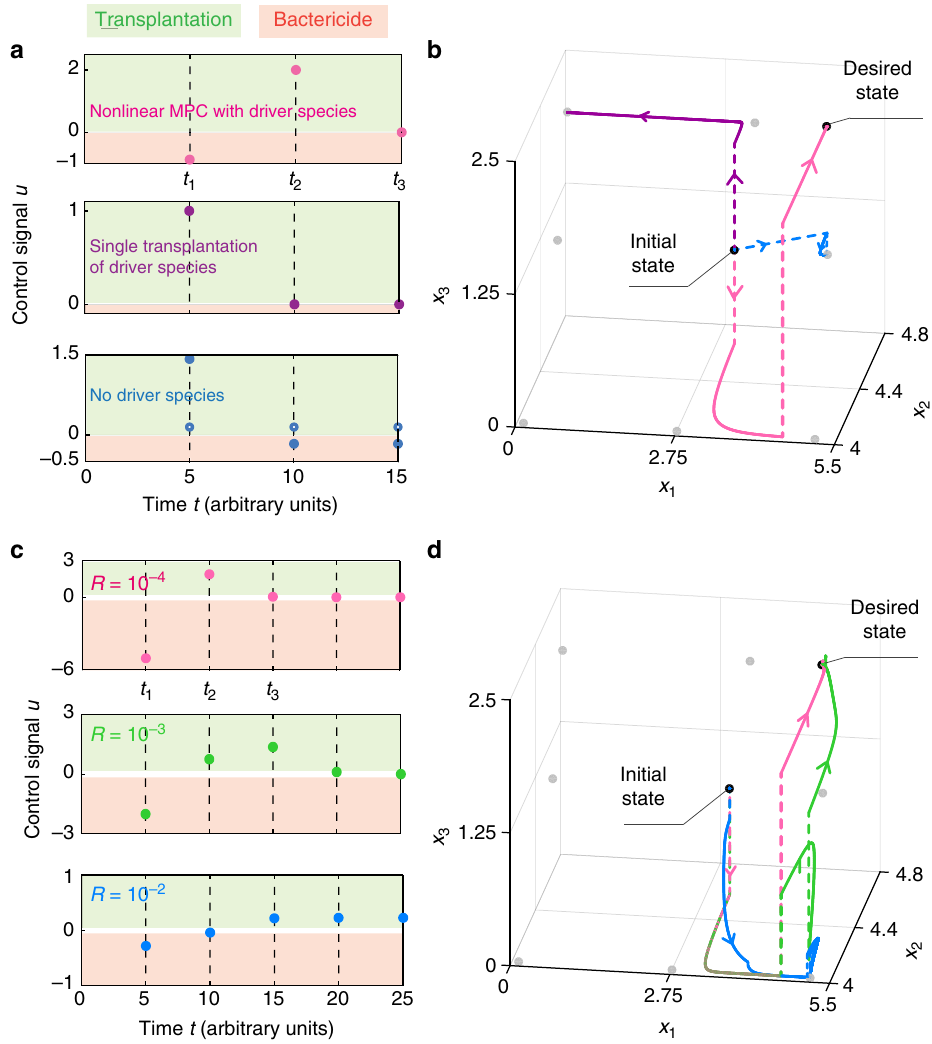
Fig. 4 Success and failure of different control strategies. a Three control strategies for driving the microbial community of Fig. 1a toward the desired state. First, MPC applied to the identi fi ed driver species {x 3 } (pink dots). The second control strategy increases the abundance of the driver species to match its value at the desired state x 3 ( t 1 ) = x 3,d (purple dots). The third control strategy does not actuate the driver species, but actuates the other two species {x 1 , x 2 } by setting their abundance to their desired values (i.e., x 1 ( t k ) = x 1,d and x 2 ( t k ) = x 2,d , solid and hollow blue dots, respectively). b Response of the microbial community to these three control strategies. Here and in panel ( d ), the “ jumps ” produced by the control inputs are depicted by dashed lines. The equilibria of the population dynamics are shown as gray dots. Only the MPC applied to the driver species succeeds in driving the community to x d . c Control strategies obtained by using the linear MPC with parameters Q ¼ diag ð 20 ; 1 ; 10 Þ and different values for R : 10 − 4 (pink), 10 − 3 (green), 10 − 2 (blue). d Trajectories of the controlled community using the linear MPC strategies described in panel ( c ). Colors correspond to the different values of Fig. 5a. The network edge-weights were chosen from a normal distribution with zero mean and standard deviation σ > 0, where σ characterizes the typical interspecies interaction strength. Nega- tive self-loops with weights − 1 were added to each species. We used this ecological network to identify the driver species of the community, and its corresponding weighted adjacency matrix as the interaction matrix to construct the linear MPC. We simulated the population dynamics of these communities using Eq. (5) 2 R N as equilibrium. The resulting com- ensuring all share x d munities have nonlinear population dynamics, and their linear- ization at the desired state is different from the interaction matrix used for the linear MPC (Supplementary Note 8).